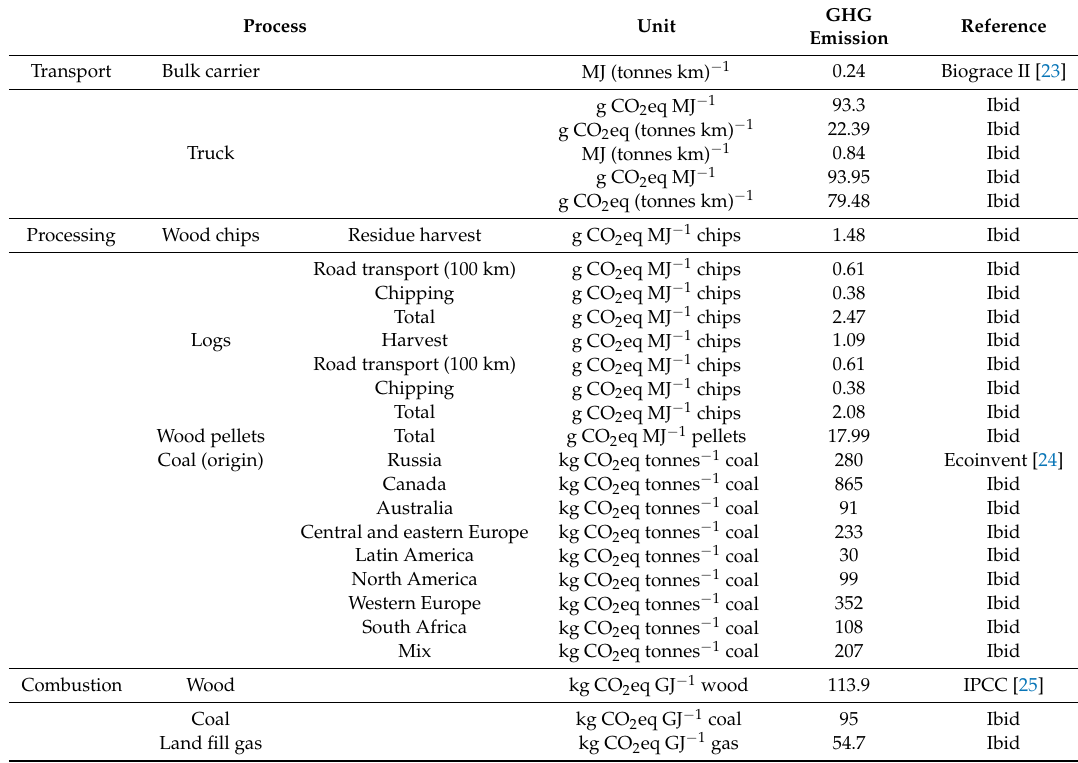
Table 2. GHG emission factors used in the